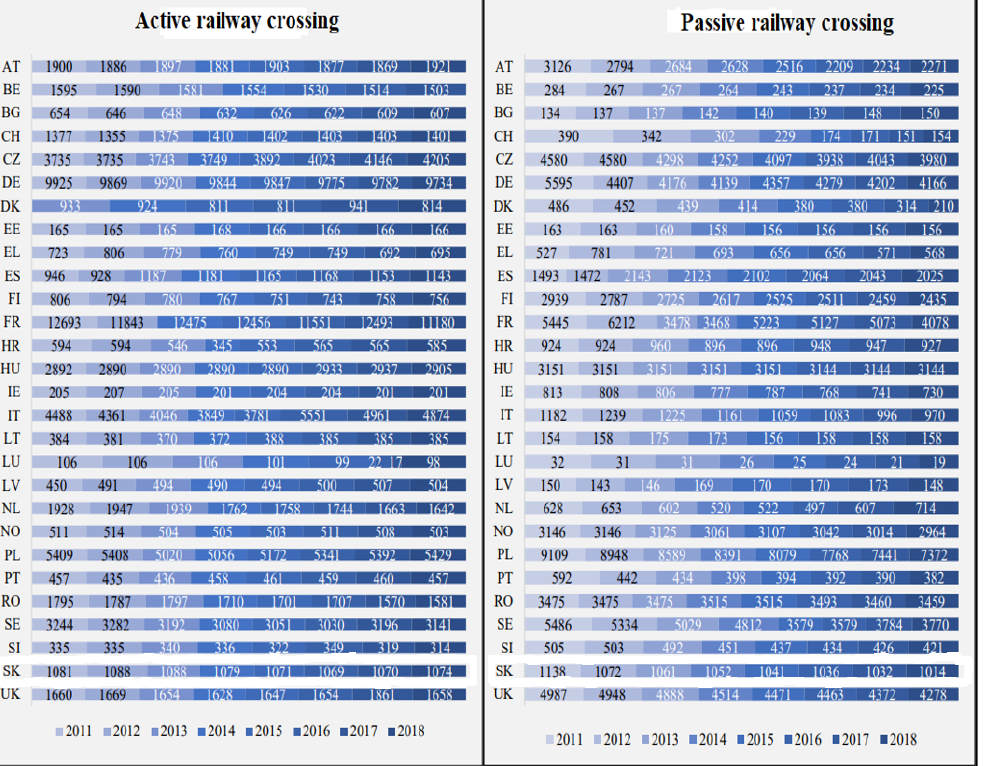
Figure 3. Number of rail crossings in the ERA infrastructure managers according to the type of rail crossing [30].